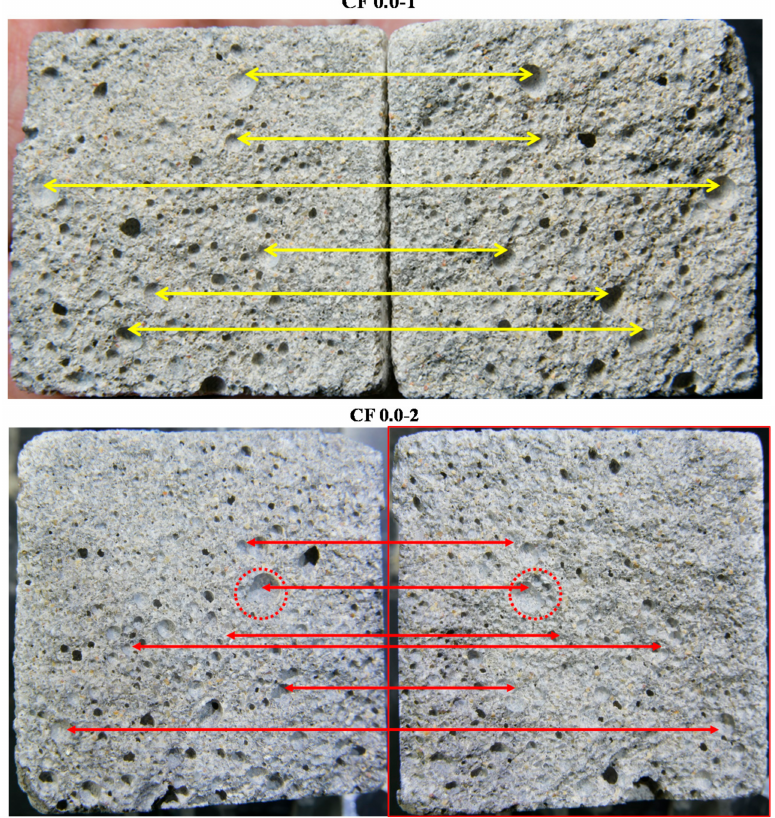
Figure 6. Cracked surfaces of both sides. The dark spots represent air